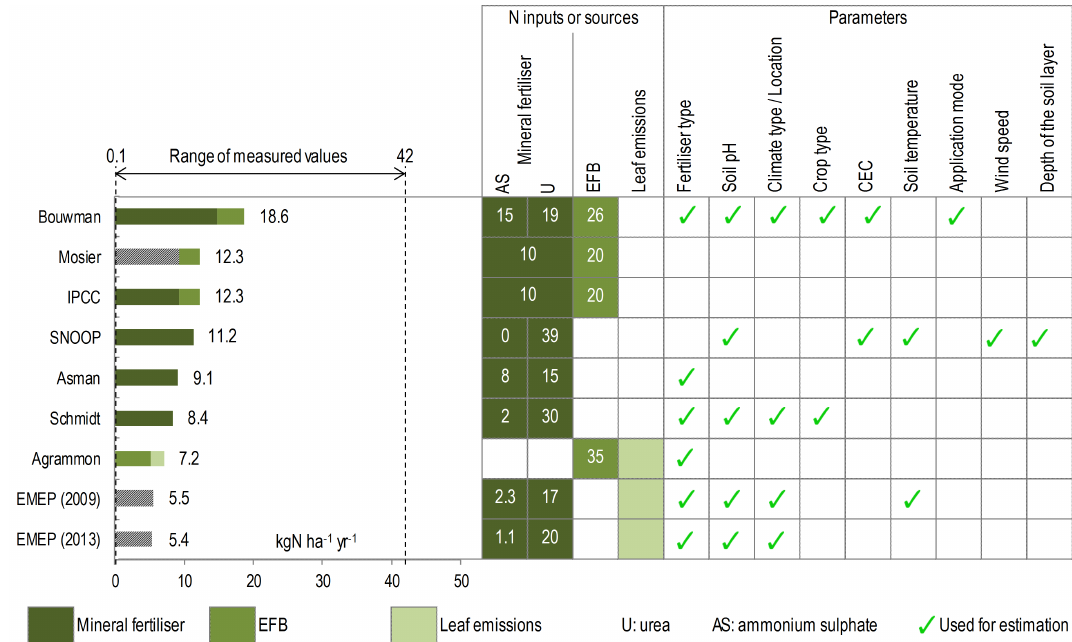
Figure 5. Comparison of annual average losses through NH 3 volatilisation, estimated by nine sub-models. The average emissions from mineral fertiliser were estimated at 9.2kg Nha − 1 yr − 1 . The emission factors for urea and ammonium sulfate differed considerably between models, ranging from 10 to 39% and 1.1 to 15%, respectively. The hatched bars represent calculations that include several sources at once: in Mosier, NH 3 emissions from mineral fertiliser include NO x emissions, and in EMEP-2009 and EMEP-2013, emissions from mineral fertiliser include those from leaves. Measured values are from Pardon et al. (2016). The table shows the N inputs and parameters used by the sub-models, and emission factors for linear relationships. Emission factors are in % of N inputs. EFB: empty fruit bunches, i.e. organic